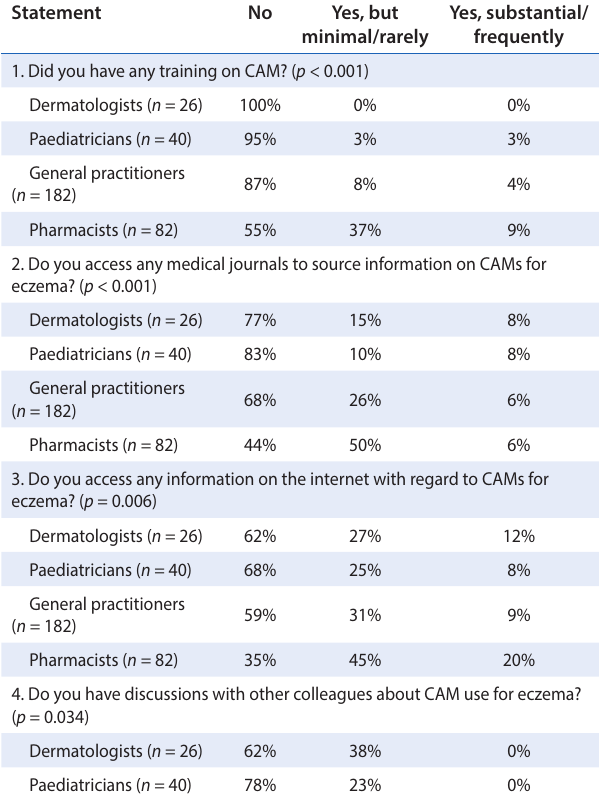
Table 4: South African healthcare professionals’ education regarding CAM